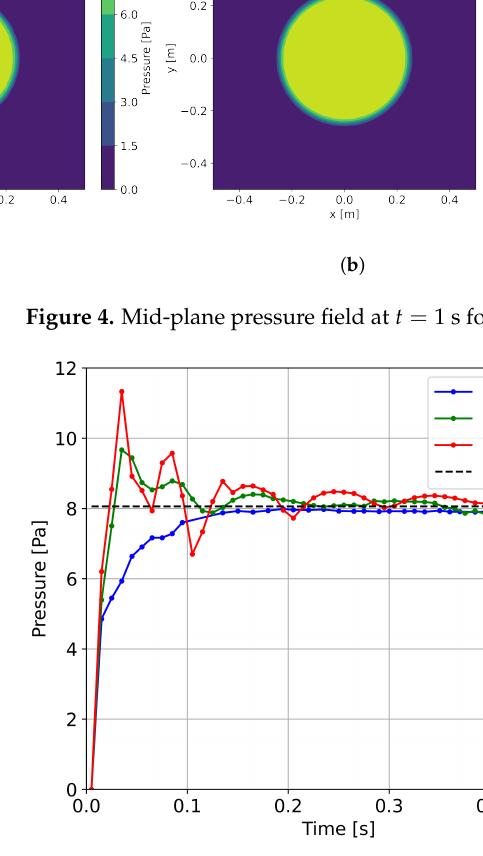
Figure 5. Time evolution of the pressure difference between fluid phases.